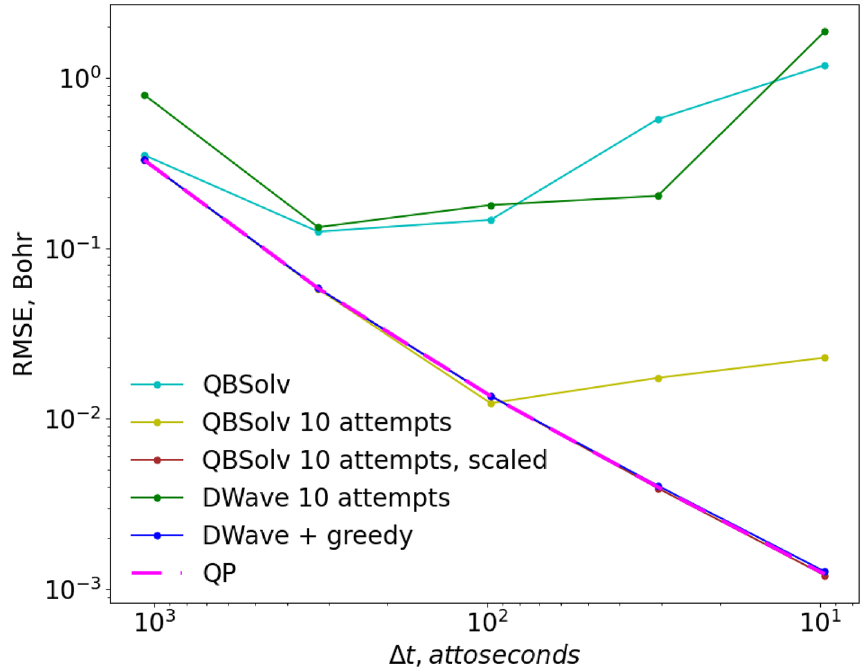
Figure 5. RMSE of solutions obtained with different methods as a function of the total number of points in the grid. All methods propagate both equations at